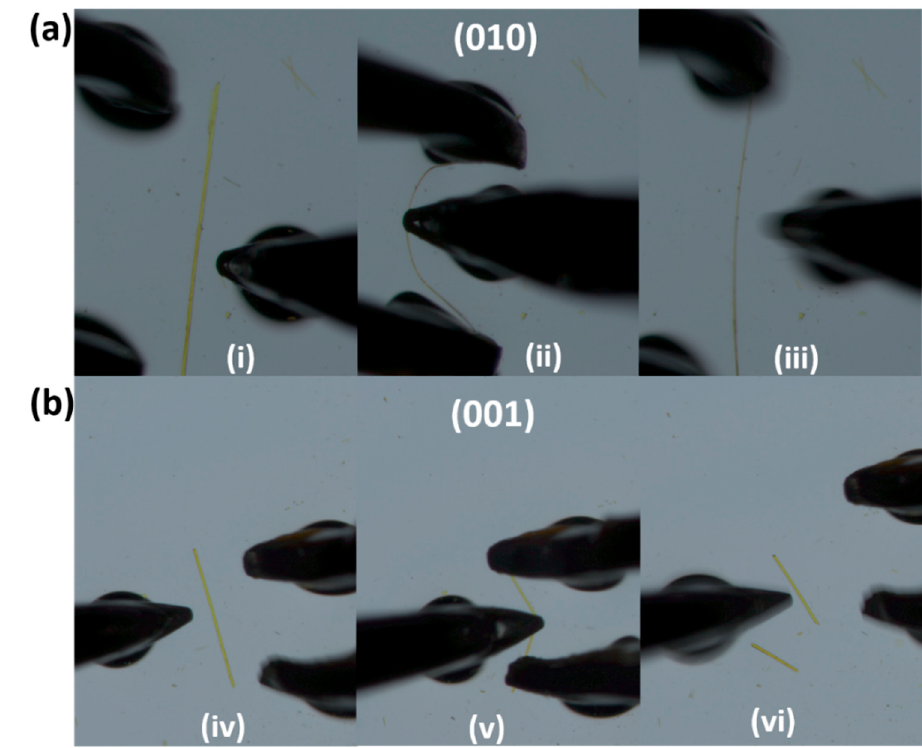
Figure 2. Optical microscope photographs of ( a ) elastic bending, and ( b ) brittle fracture of BCPIN crystal over (010) and (001) crystallographic faces upon mechanical stress, respectively.